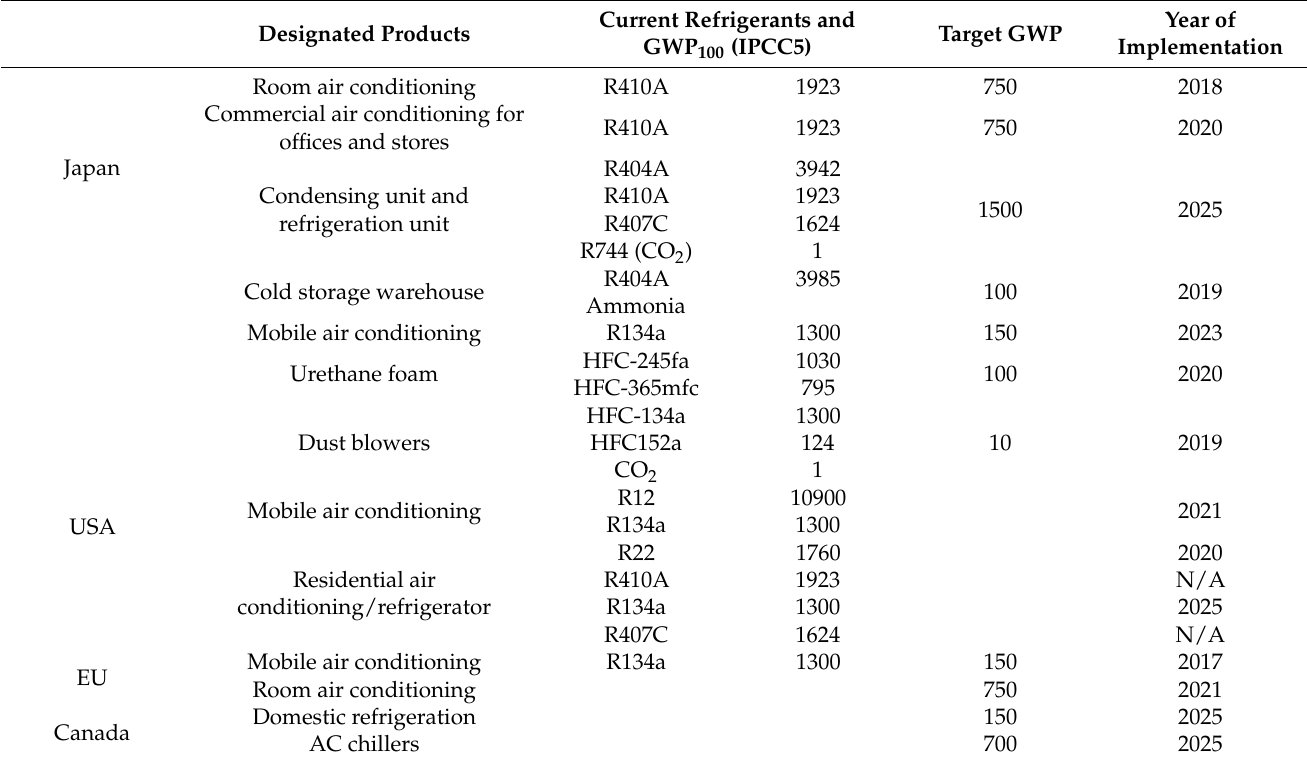
Table 2. Current GWP and target low-GWP refrigerants implementation plan [34,36,37,39,40].